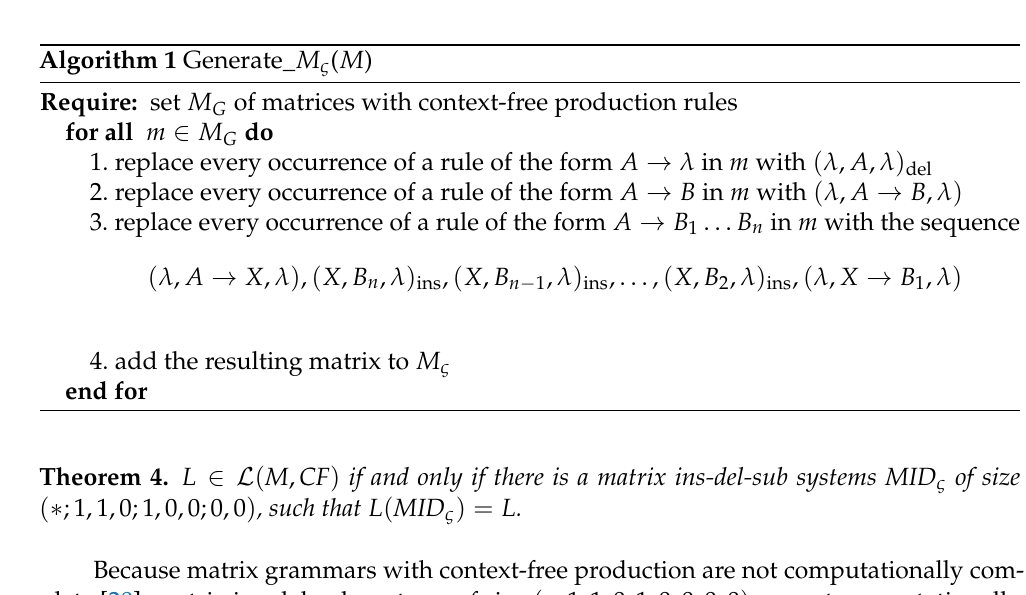
Figure 3. The tree group following the application of ( λ , a , λ ) ins